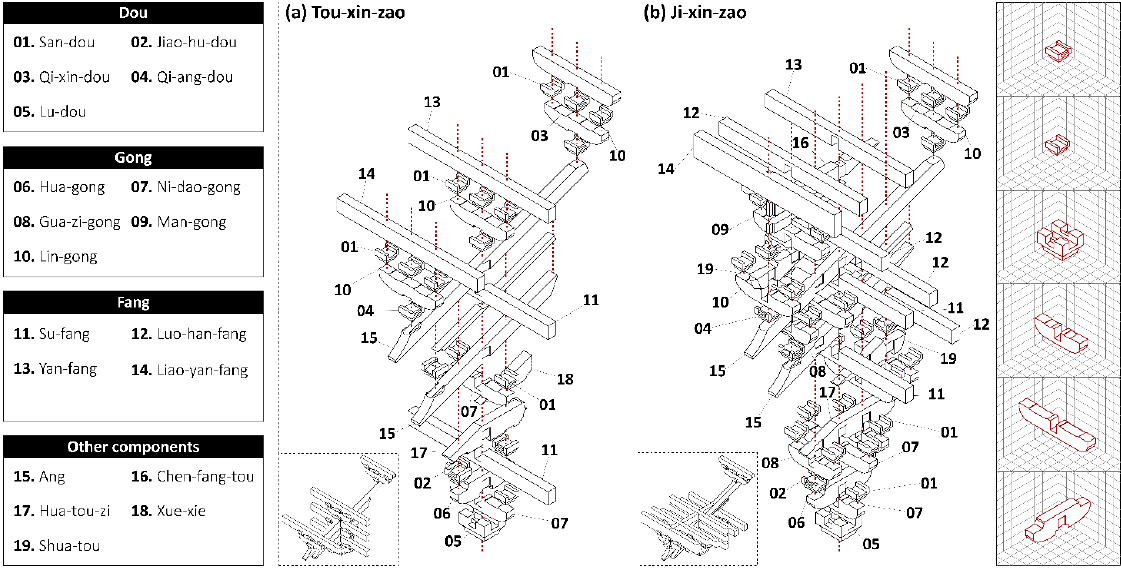
Figure 4. Overview of the two Dou-gongs involved in this study. ( a ) Tou-xin-zao; ( b ) Ji-xin-zao.